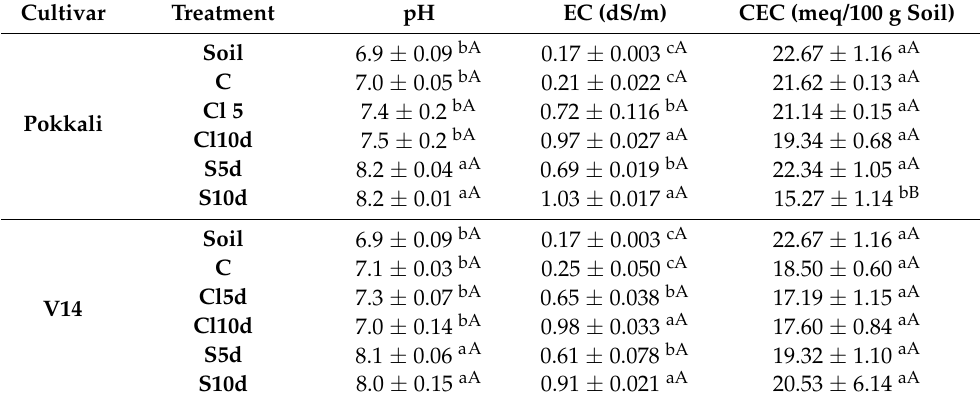
Table 1. Hydrogen potential (pH), electric conductivity (EC) and cation exchange capacity (CEC) of uncultivated and unsalted soil (Soil), unsalted soil cultivated with control plant (C) and